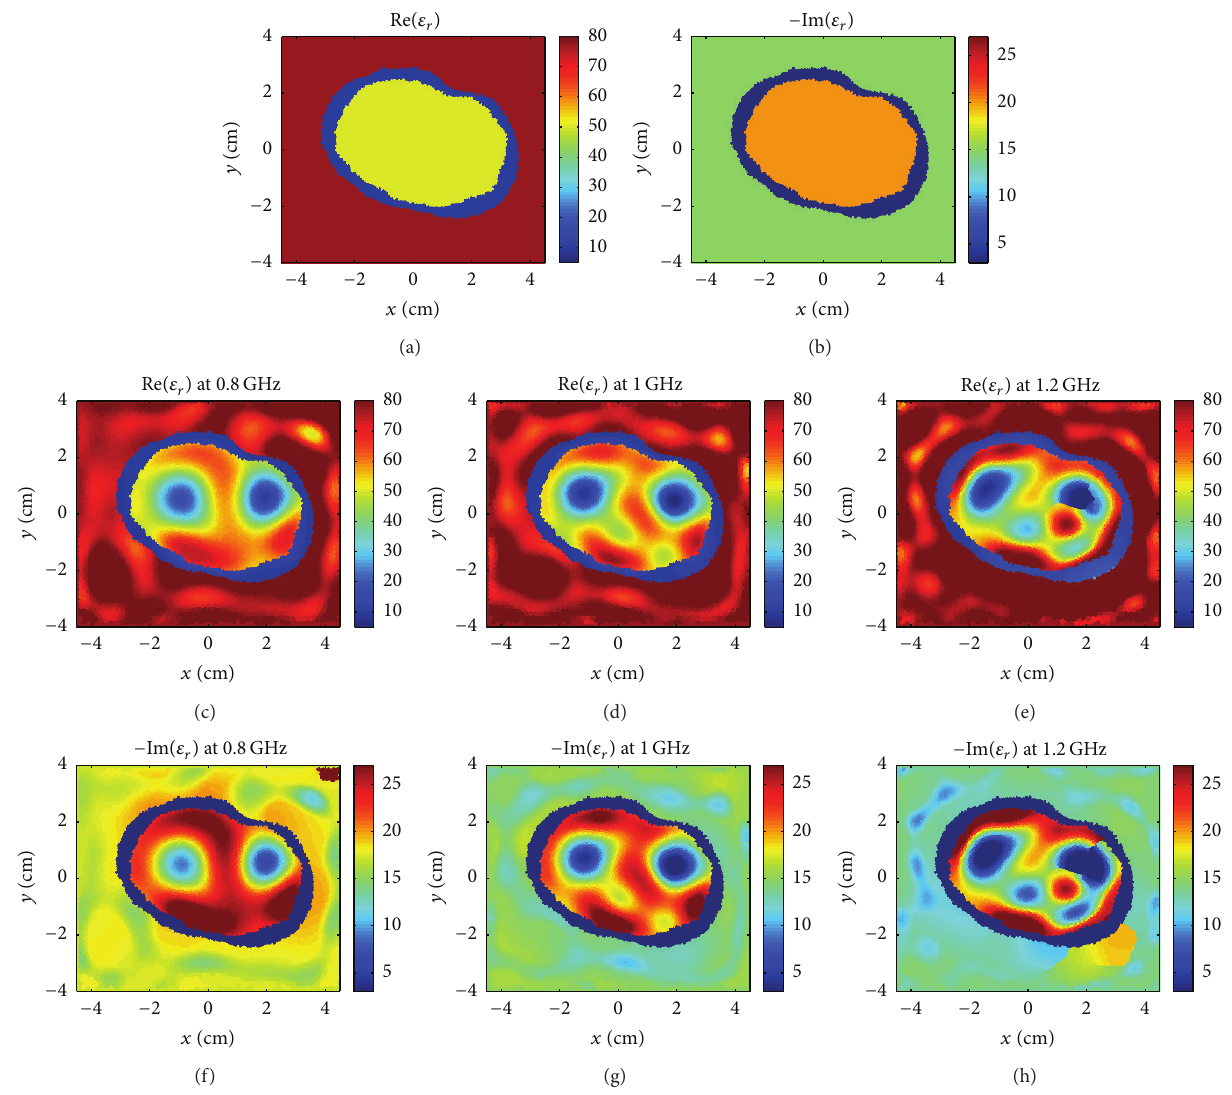
Figure 13: Volunteer 4: (a)-(b) prior information. The reconstruction when prior information is used as inhomogeneous background at (c), (f) 0.8 GHz, (d), (g) 1GHz, and (e), (h)